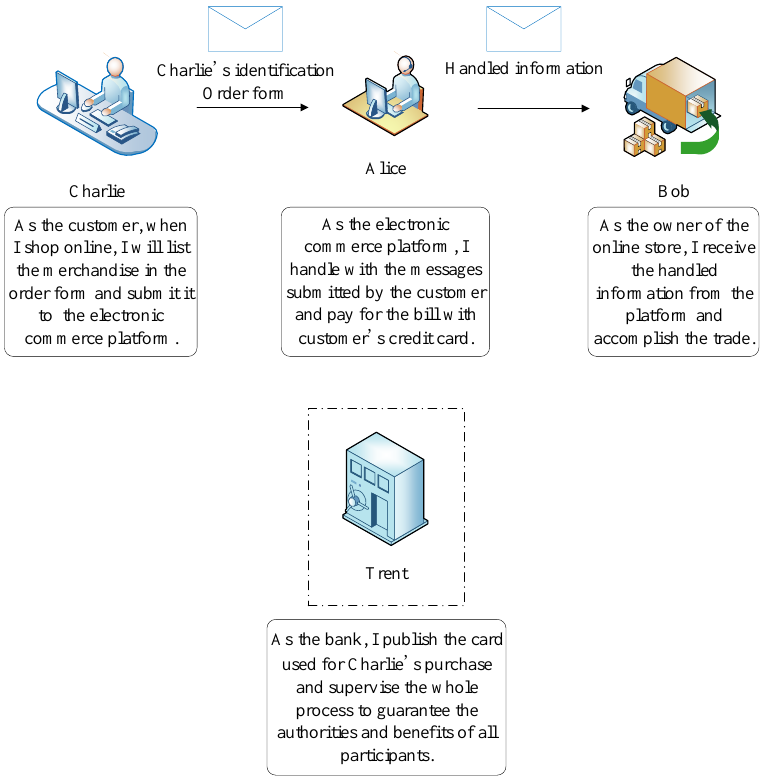
Figure 7. Application scene of our presented proxy signature scheme in electronic